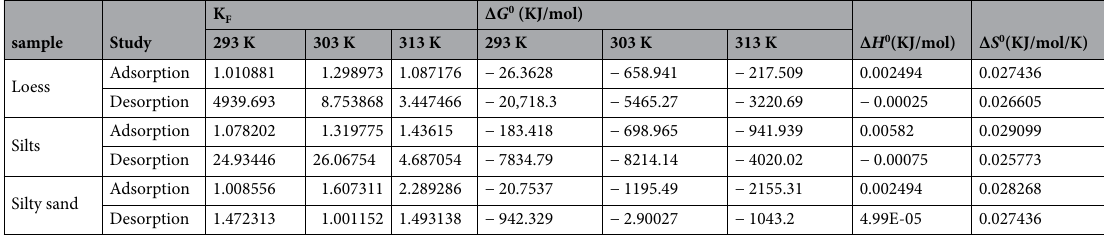
Table 5. Thermodynamic parameters for Phenanthrene adsorption in the three tested soils.